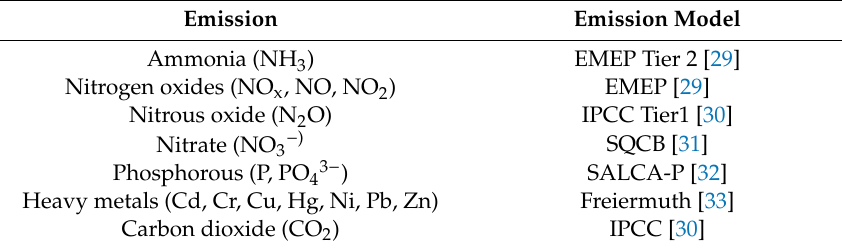
Table 4. Emission models used (adapted from